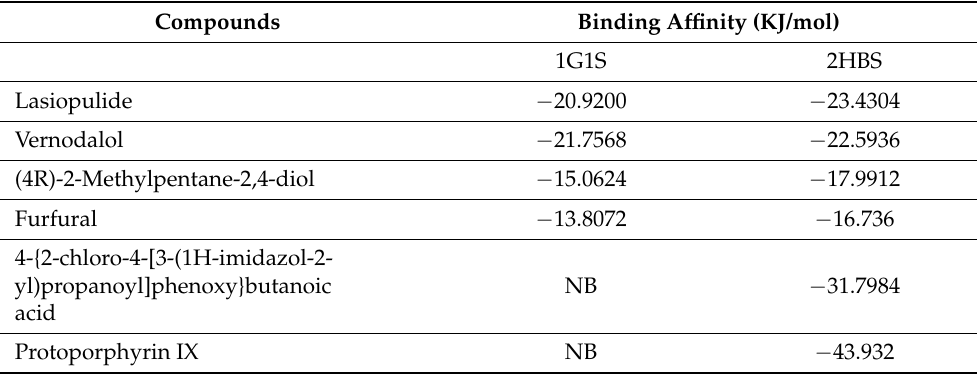
Table 4. Docking energies (KJ/mol) of the isolated compounds with target proteins. Compounds Binding Affinity (KJ/mol) 1G1S 2HBS Lasiopulide − 20.9200 − 23.4304 Vernodalol − 21.7568 − 22.5936 (4R)-2-Methylpentane-2,4-diol − 15.0624 − 17.9912 Furfural − 13.8072 − 16.736 4-{2-chloro-4-[3-(1H-imidazol-2- yl)propanoyl]phenoxy}butanoic NB − 31.7984 acid Protoporphyrin IX NB −